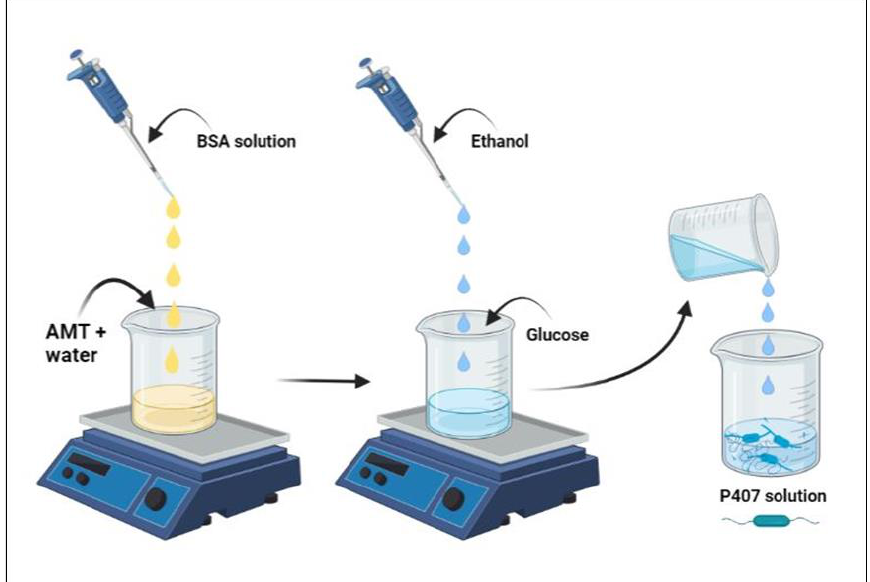
Figure 9. Preparation of AMT-loaded in situ gelling thermoresponsive nasal gel formulation. Illus- tration was created using BioRender (https://biorender.com/), accessed on 13 November